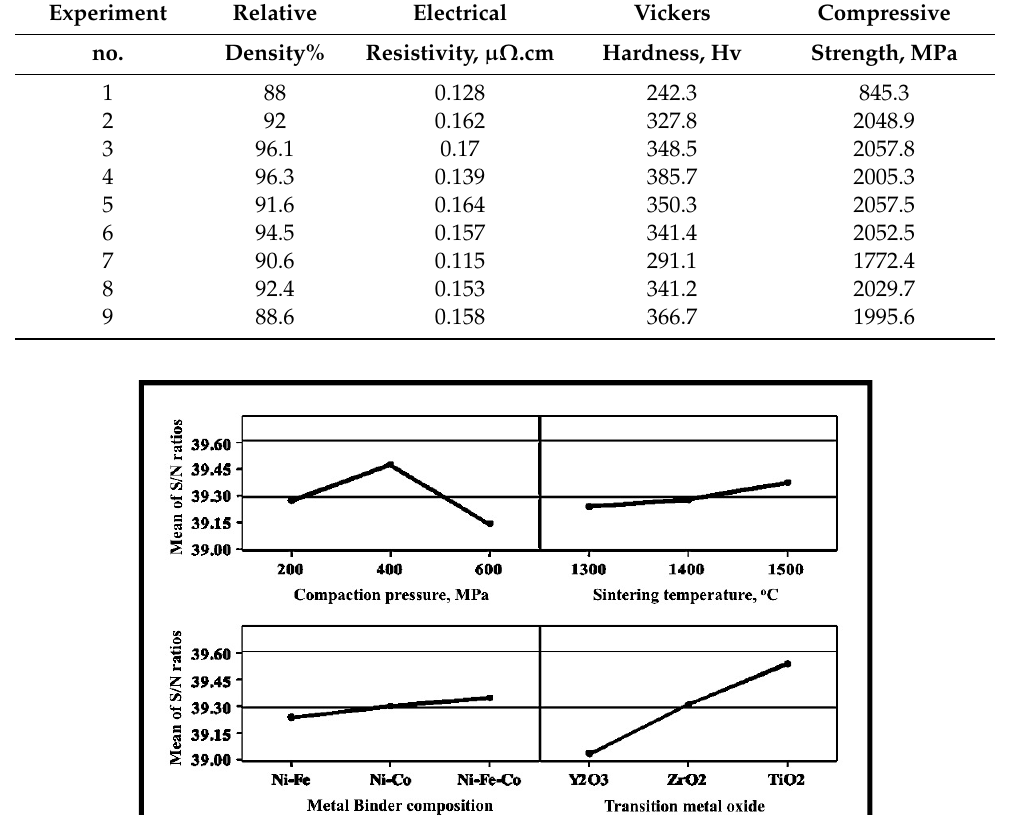
Table 2. Experimental results.